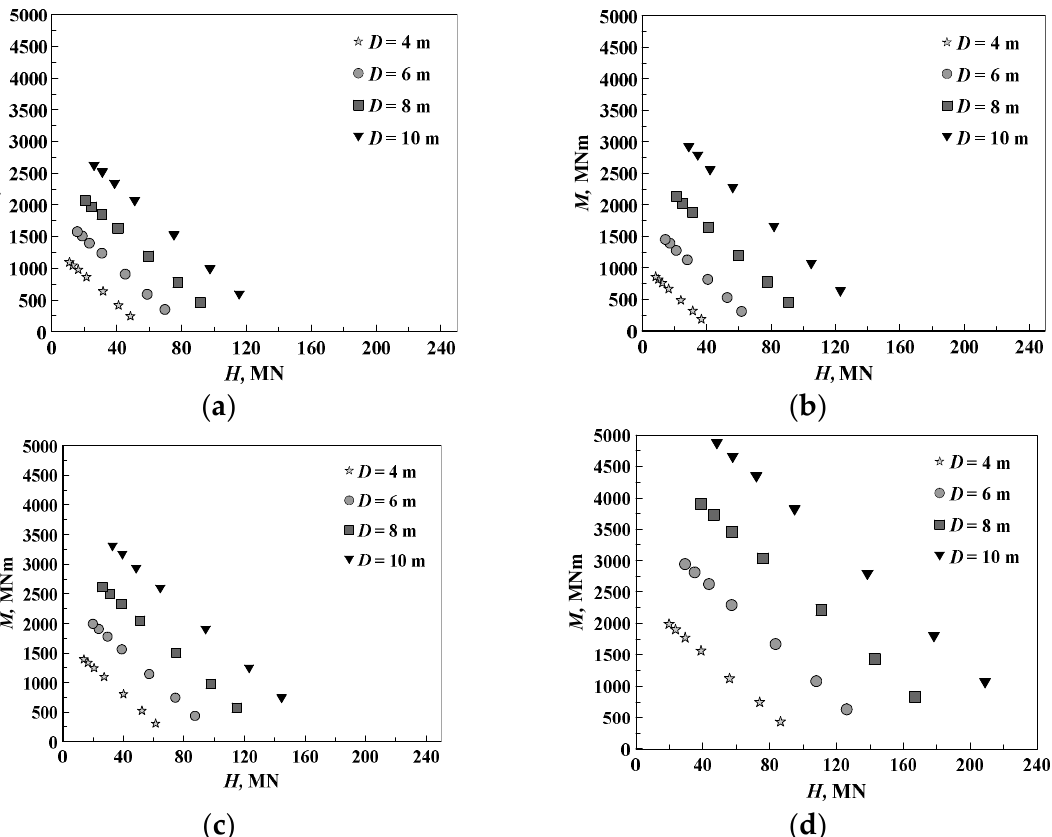
Figure 12. Force–moment diagram of monopiles in 65% relative density under different deflection criteria: ( a ) 10% D , ( b ) 2°, ( c ) 4°, ( d ) ultimate.